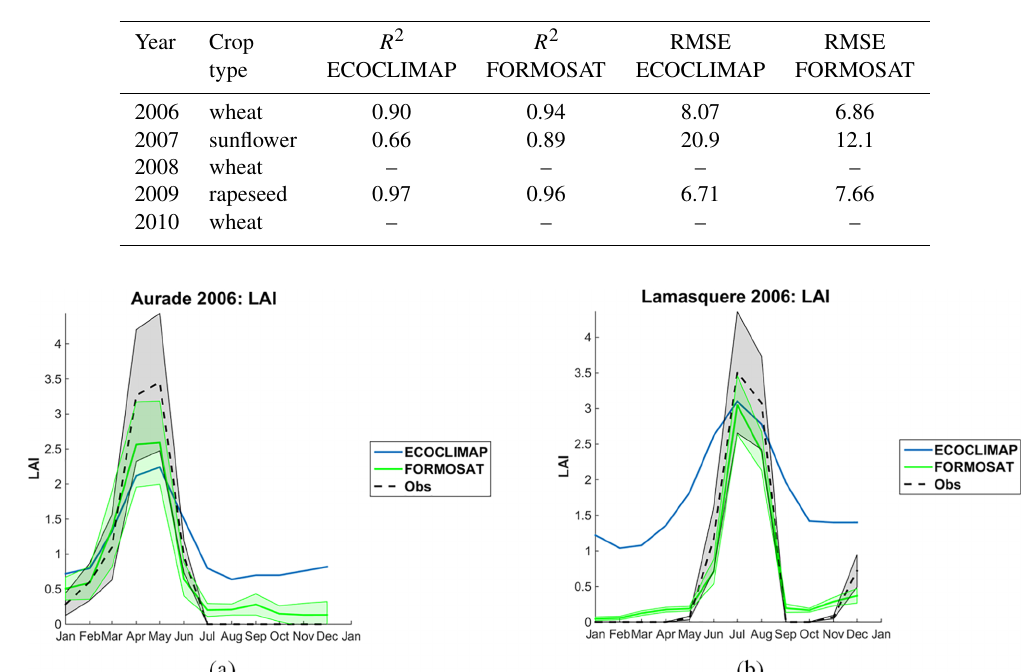
Table 2. Correlation coefficient and RMSE of evapotranspiration for the Auradé site.